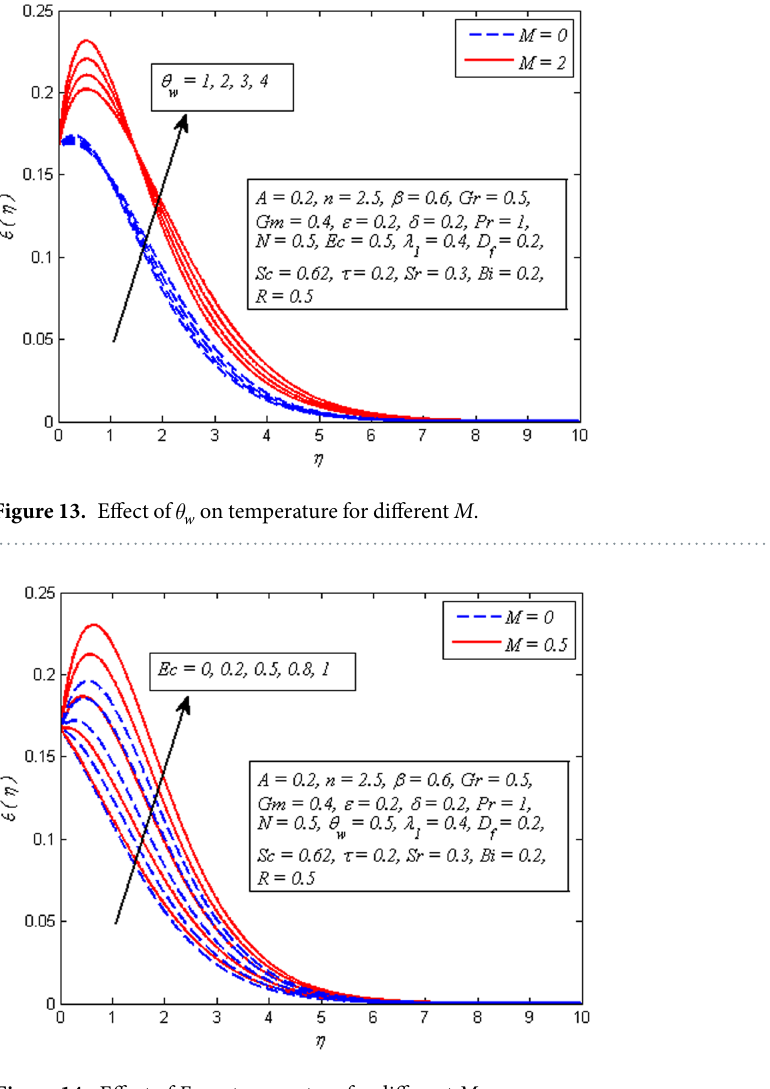
Figure 14. Effect of Ec on temperature for different M